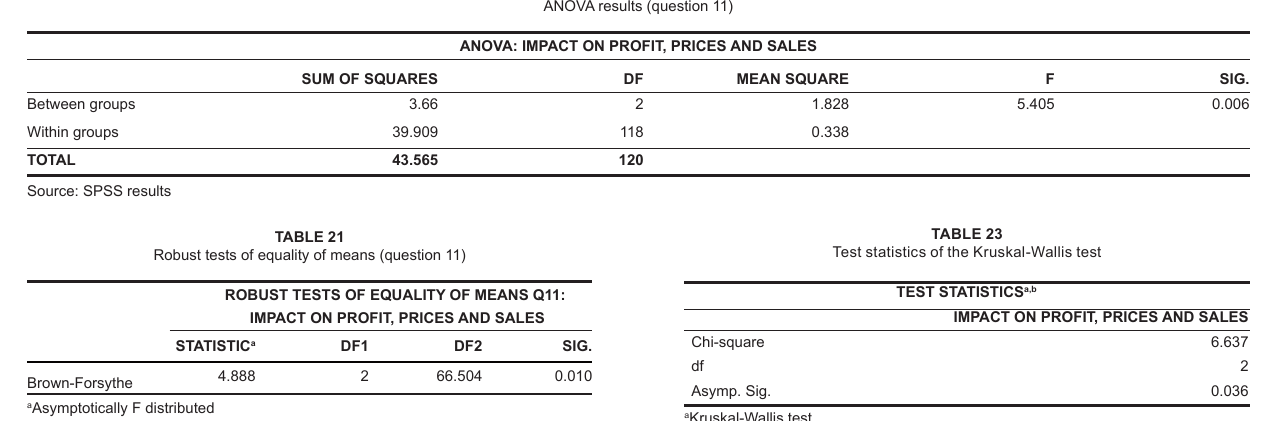
TABLE 20 ANOVA results (question 11)